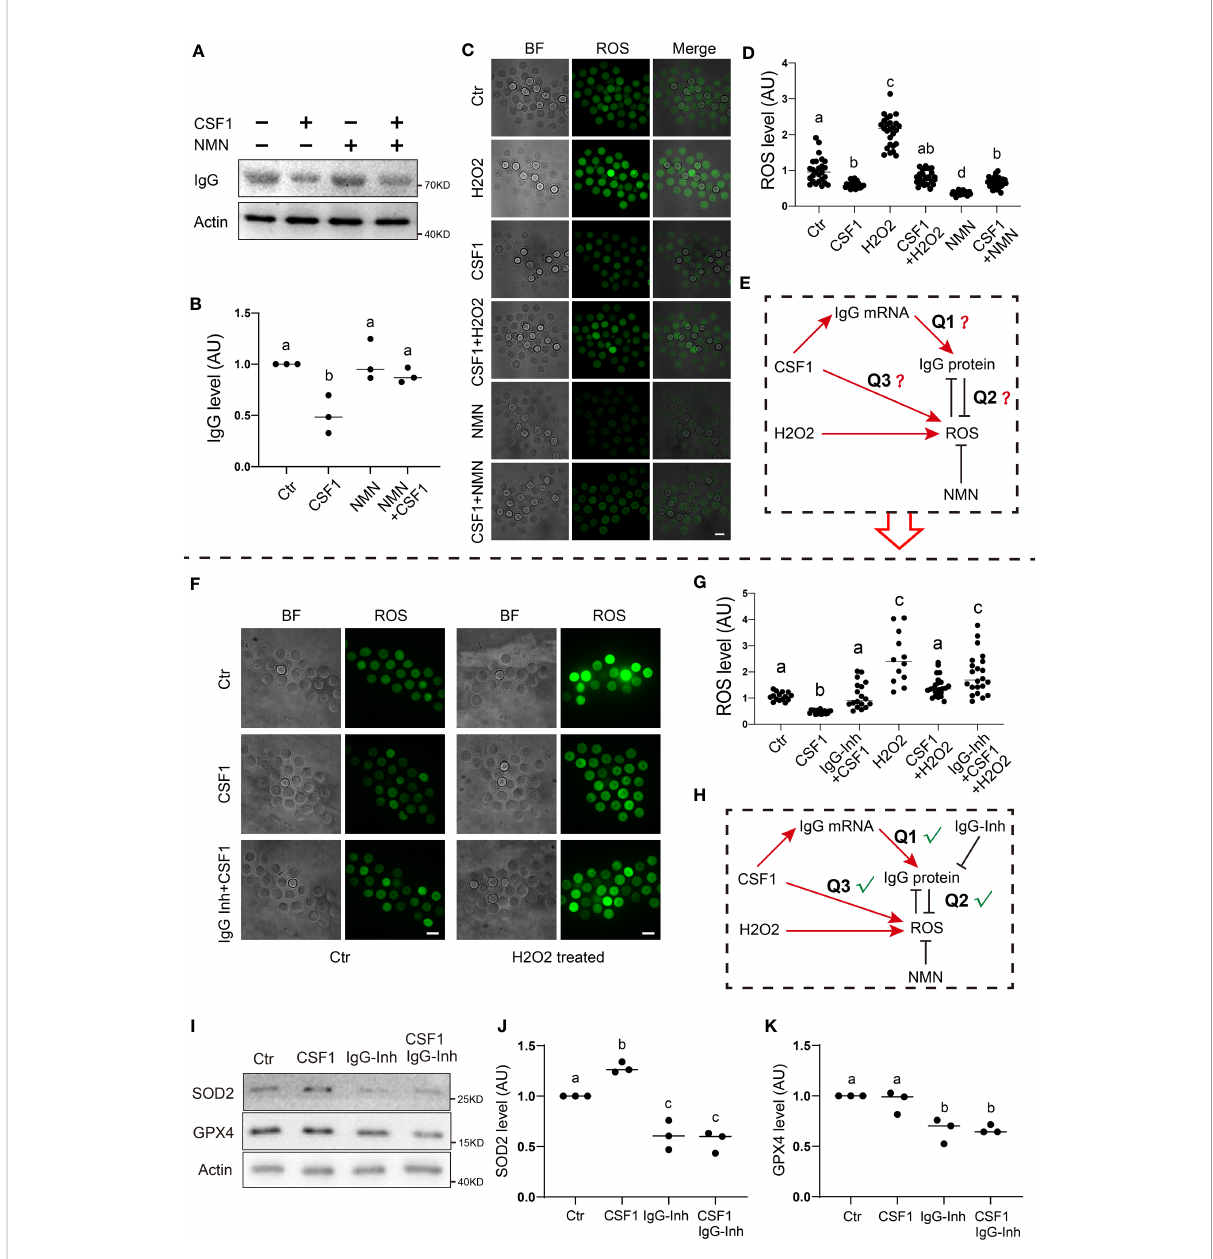
FIGURE 5 IgG functions to eliminate ROS production in response to CSF1 stimuli (A, B) Western blot and quanti fi cation show that on exposure to CSF1 stimuli, IgG levels signi fi cantly decreased about one-fold. NMN supplement signi fi cantly raised the IgG level close to the control level. (C, D) ROS live fl uorescence shows that on exposure to CSF1 stimuli, ROS signi fi cantly decreased by about 40.1% on exposure to NMN supplement, ROS signi fi cantly decreased over one-fold on exposure to H2O2 stimuli, ROS signi fi cantly increased by more than one-fold. CSF1 co-supplement with NMN raised the ROS level in NMN-treated oocytes to close to the control level CSF1 co-supplement with H2O2 reduced the ROS level in H2O2- treated oocytes to near the control level. (E) Model hypothesis for (A – D) CSF1-induced IgG increment might be used to eliminate ROS production on exposure to either CSF1 or H2O2 treatment. (F, G) ROS live fl uorescence shows that on exposure to CSF1 stimuli, ROS signi fi cantly decreased by about 53.7% while IgG co-inhibition signi fi cantly raised the ROS level close to the control level. On exposure to H2O2 stimuli, ROS signi fi cantly increased by more than one-fold the CSF1 co-supplement reduced the ROS level in H2O2-treated oocytes to close to the control, whereas IgG inhibition+CSF1+H2O2 signi fi cantly increased the ROS level compared with the CSF1+H2O2 group. (H) Model hypothesis for A-G: CSF1 treatment could induce both IgG and ROS increment increased IgG can be used to counteract the increment of ROS on exposure to CSF1 or H2O2 stimuli. (I-K) Western blot and quanti fi cation show that SOD2 signi fi cantly increased in response to CSF1, while decreased upon IgG inhibition or CSF1 treatment plus IgG inhibition GPX4 level was not affected by CSF1 treatment but decreased upon IgG inhibition. Actin was used as a loading control. Scale bars, 20 m m. Difference lower-case letters indicate signi fi cant difference between two